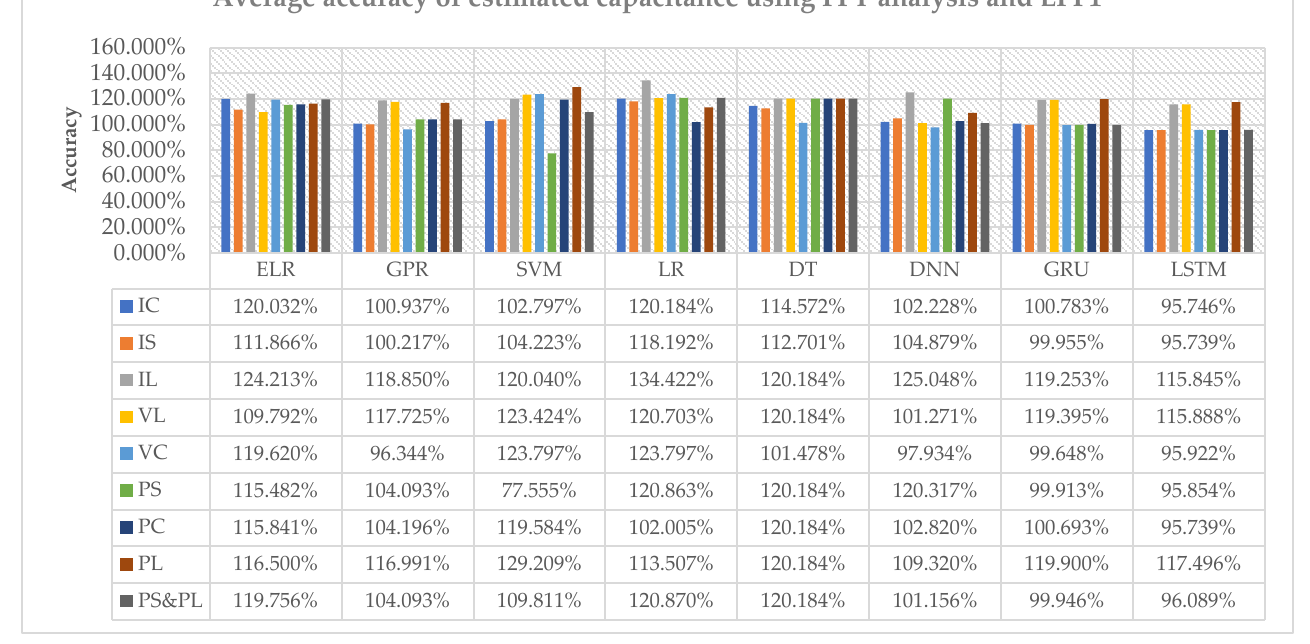
Figure 9. Average accuracy of the estimated capacitance with fast Fourier transform (FFT) analysis and low-pass filter 1.